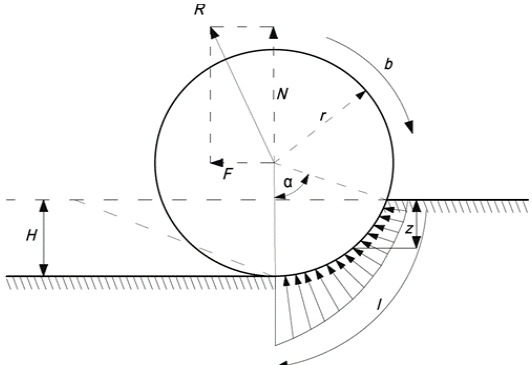
Figure 1. Forces distribution in a wheel rolling on a natural surface: N — vertical soil reaction to wheel load, F — friction force, R — resultant of F and N forces, H — rut depth, a — length of wheel and pavement contact section , α— angle corresponding to section length a, r — wheel radius, b — rotation direction, z — position of the layer concerned [25].